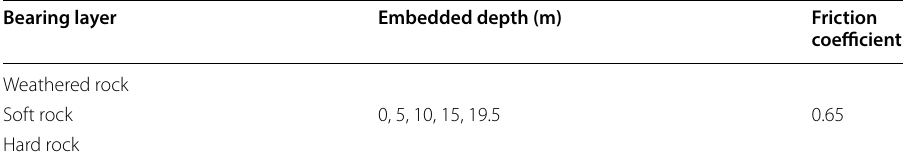
M ‑ C Mohr‑Coulomb Table 2 Summary of the soil conditions of the numerical analyses Bearing layer